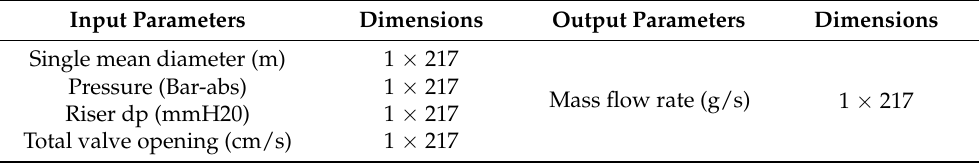
Table 2. Artificial neural network I/P & O/P parameters.